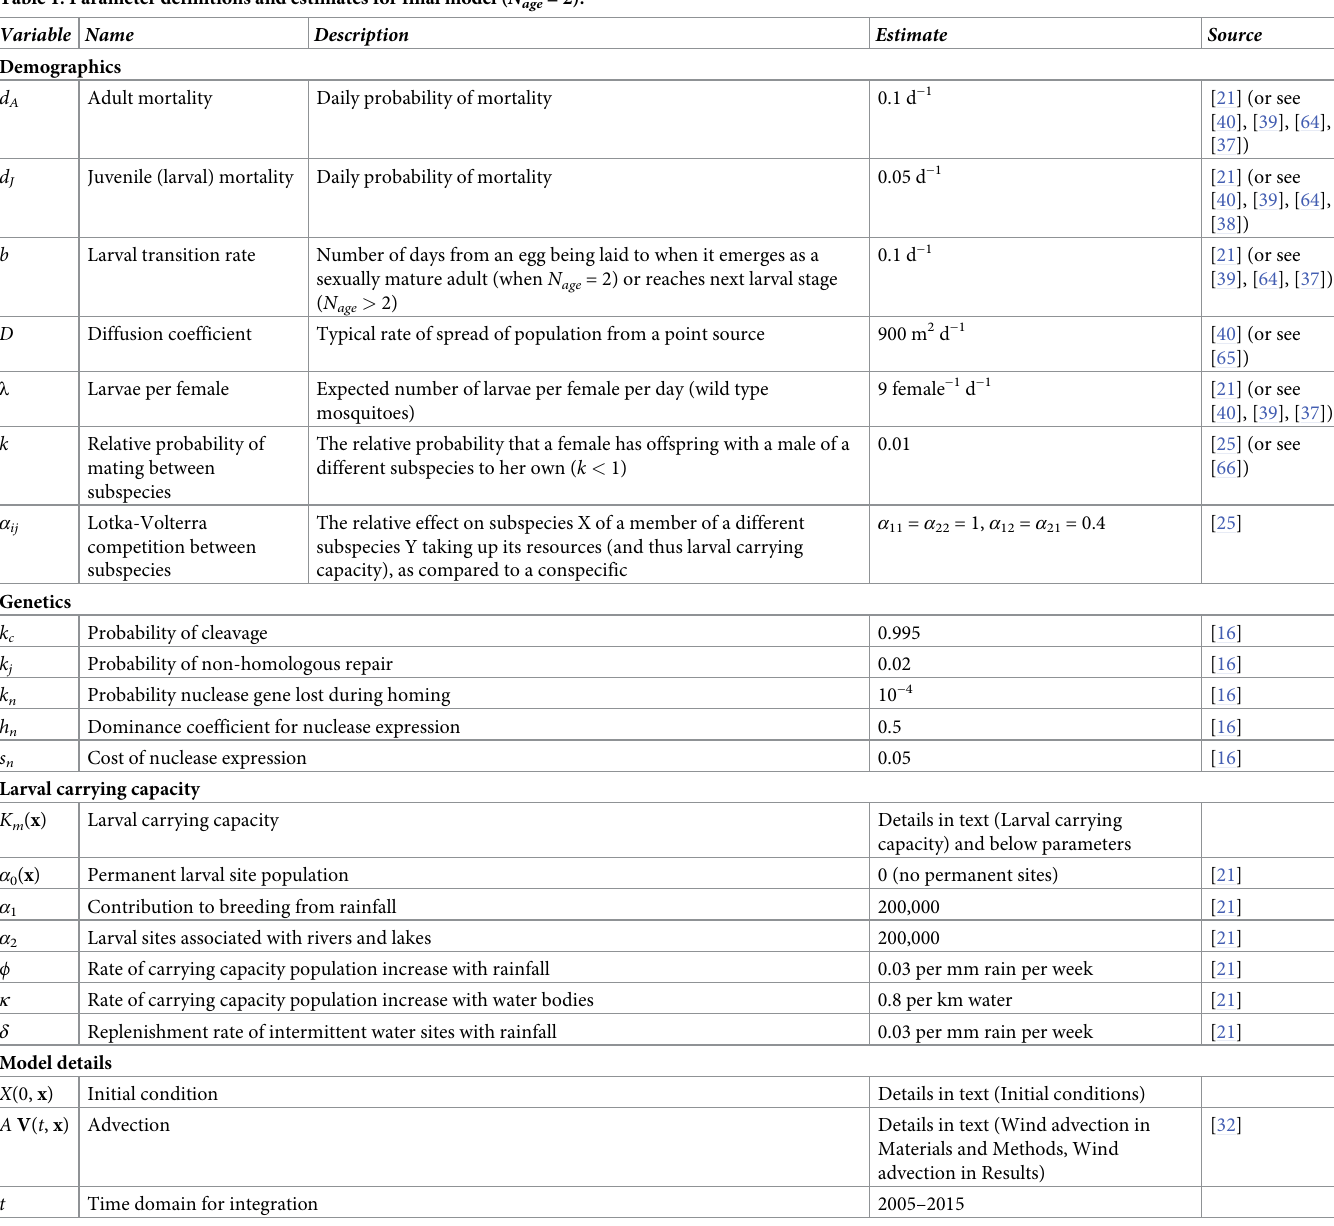
Table 1. Parameter definitions and estimates for final model ( N